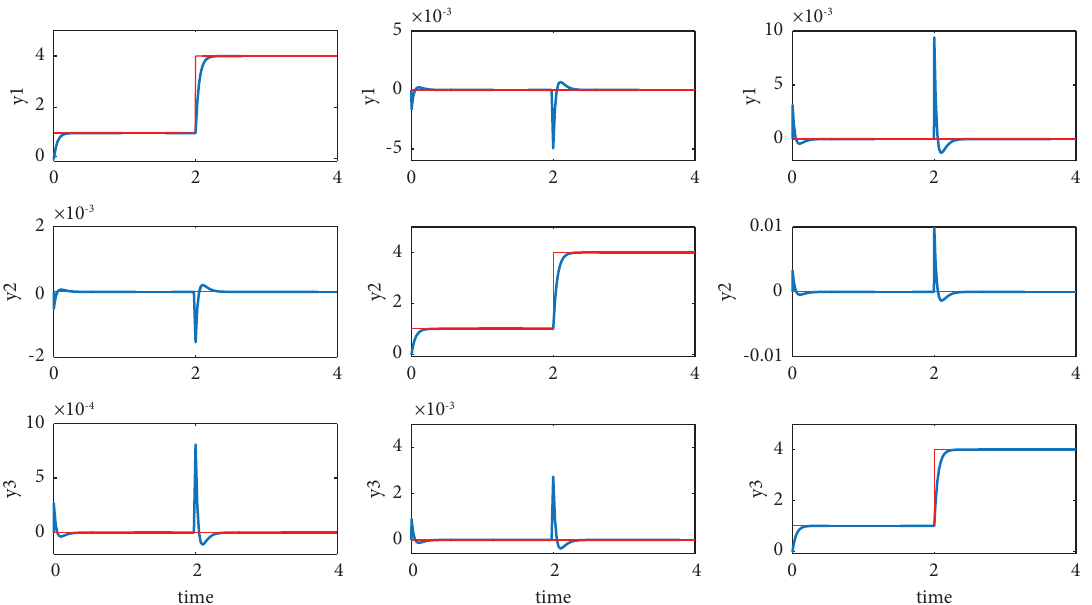
Figure 12: System step response in the third mode.